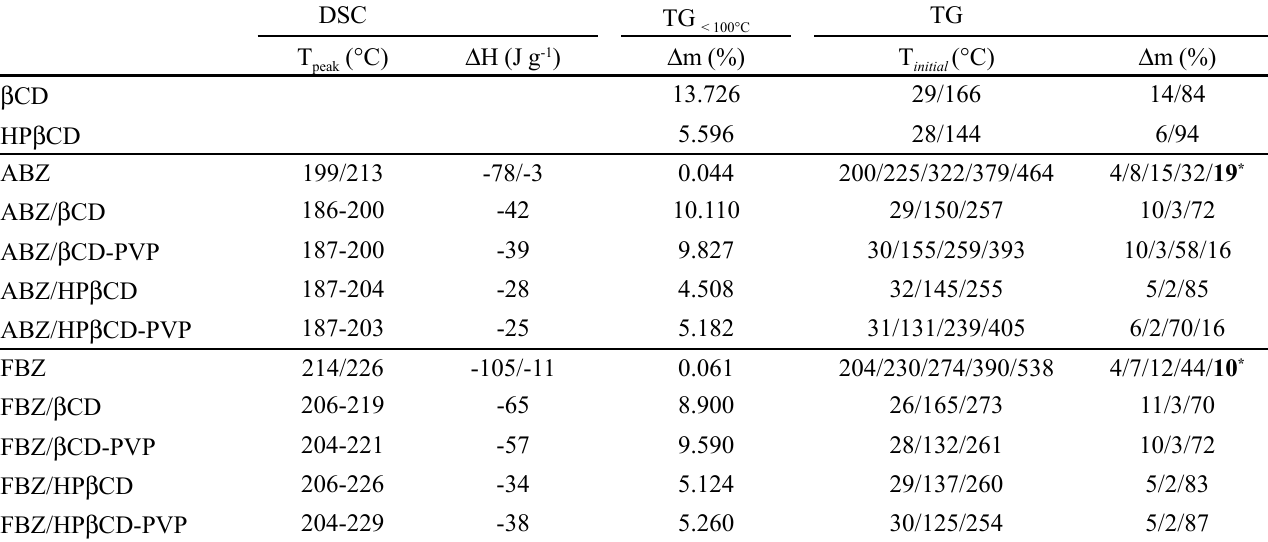
TABLE III - Thermal parameters obtained from the DSC and TG/DTG curves of the drugs (ABZ and FBZ) and binary and ternary complexes